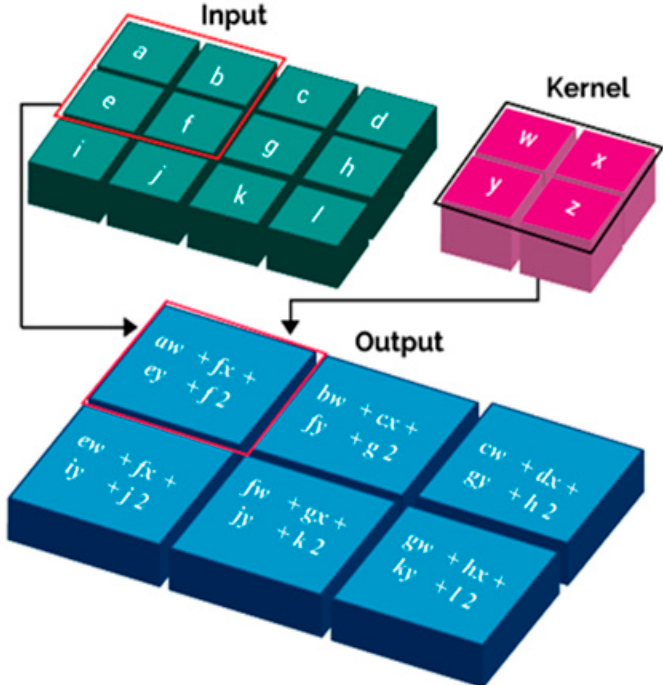
Figure 1. Illustrating the procedure of convolution in a convolutional neural network (CNN).